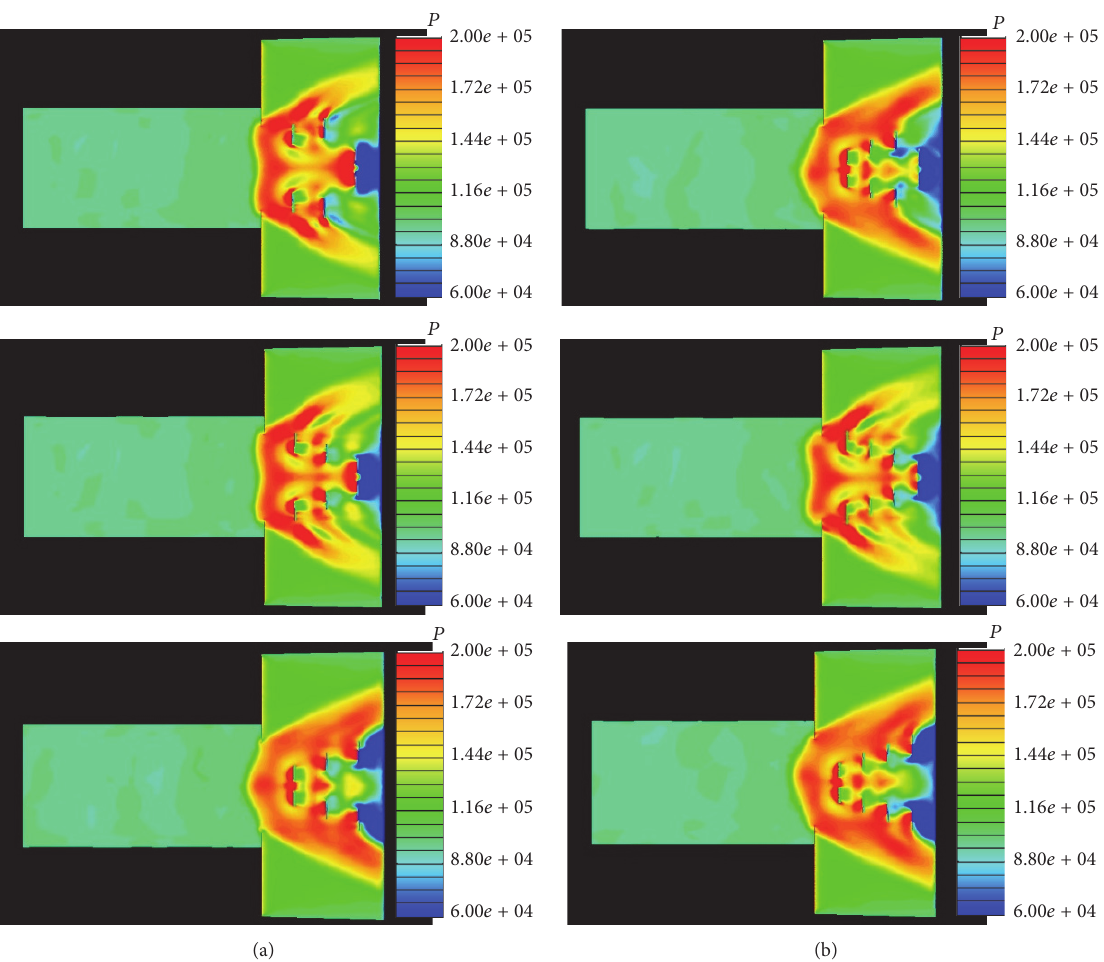
Figure 5: Computed surface pressure contours in the afterbody fin region near the microflaps, 𝑀 = 2.5 , 𝛼 = 0 ∘ : (a) 6- and (b) 8-flap cases.